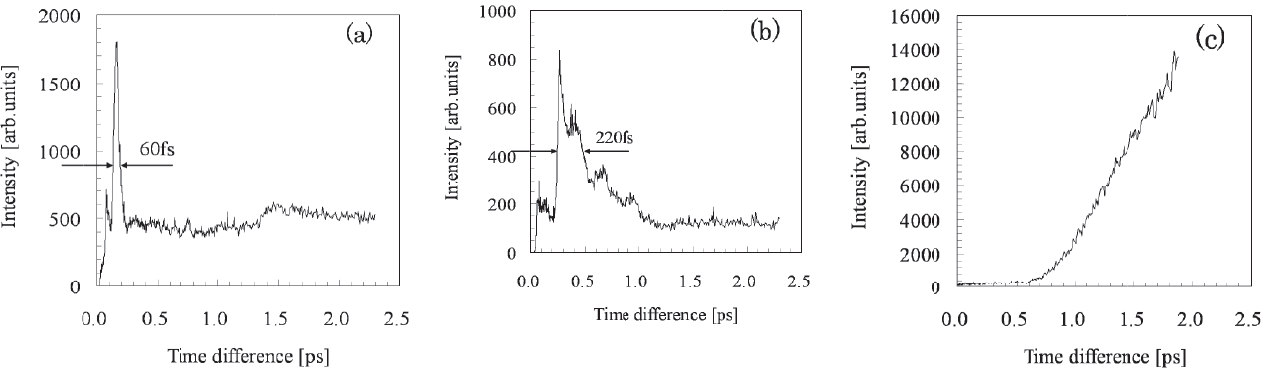
FIG. 7. Pulse elongation of the electron bunches: (a), (b) and (c) with the energy distributions as in Figs. 3(a2), 3(b2), and 3(c2), respectively, after 180 mm path, supposing initial bunch duration to be zero at the gas-jet